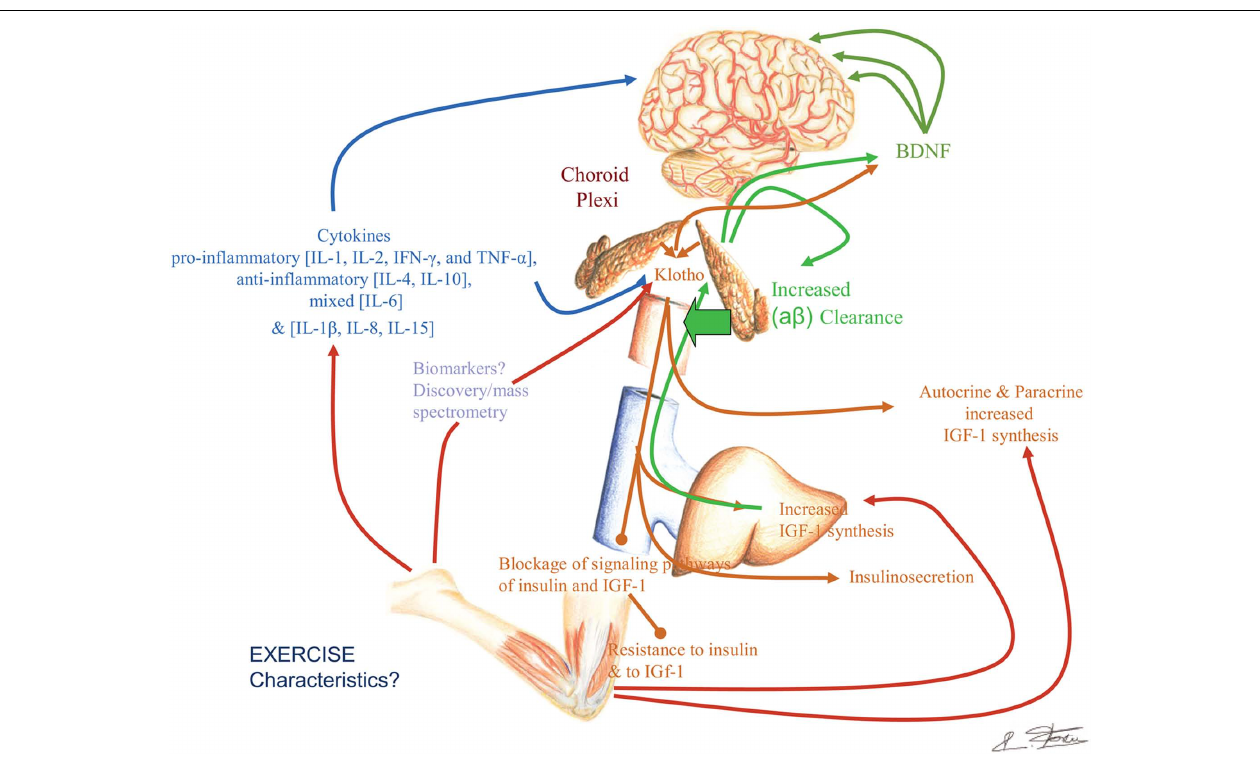
FIGURE 5 | Exercise, growth factors , myokines, Klotho, and potential effects on the